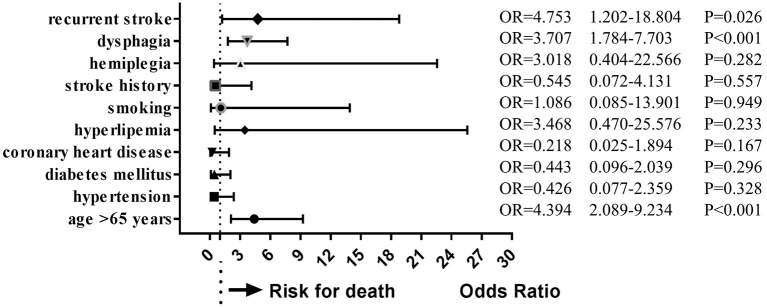
Clincal risk factors for death. Age ≥ 65 years, dysphagia, and stroke recurrence were risk factors for death.